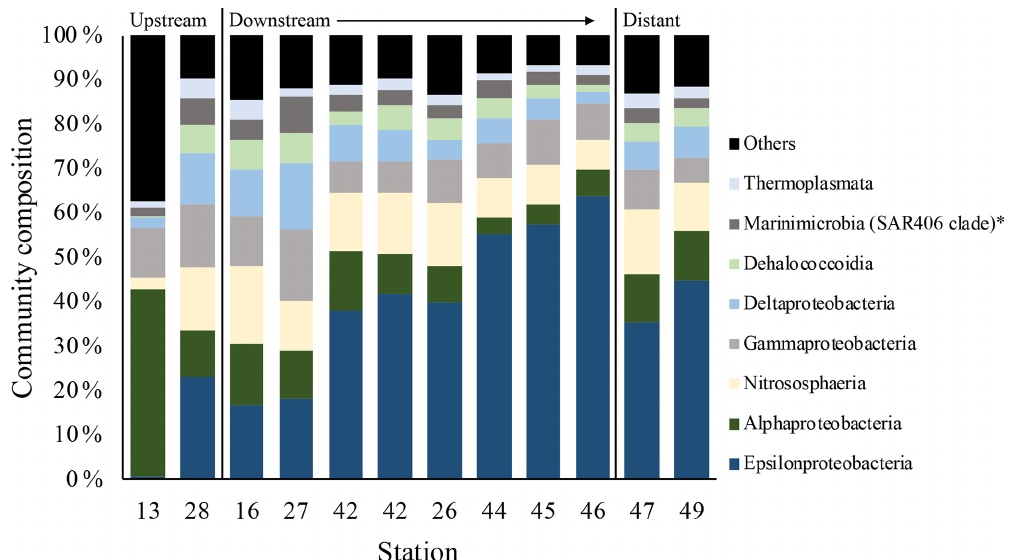
Figure 12. Microbial community composition in the plume samples as a percentage of the dominant class groups in accordance with the SIMPER results. The asterisk indicates an undefined